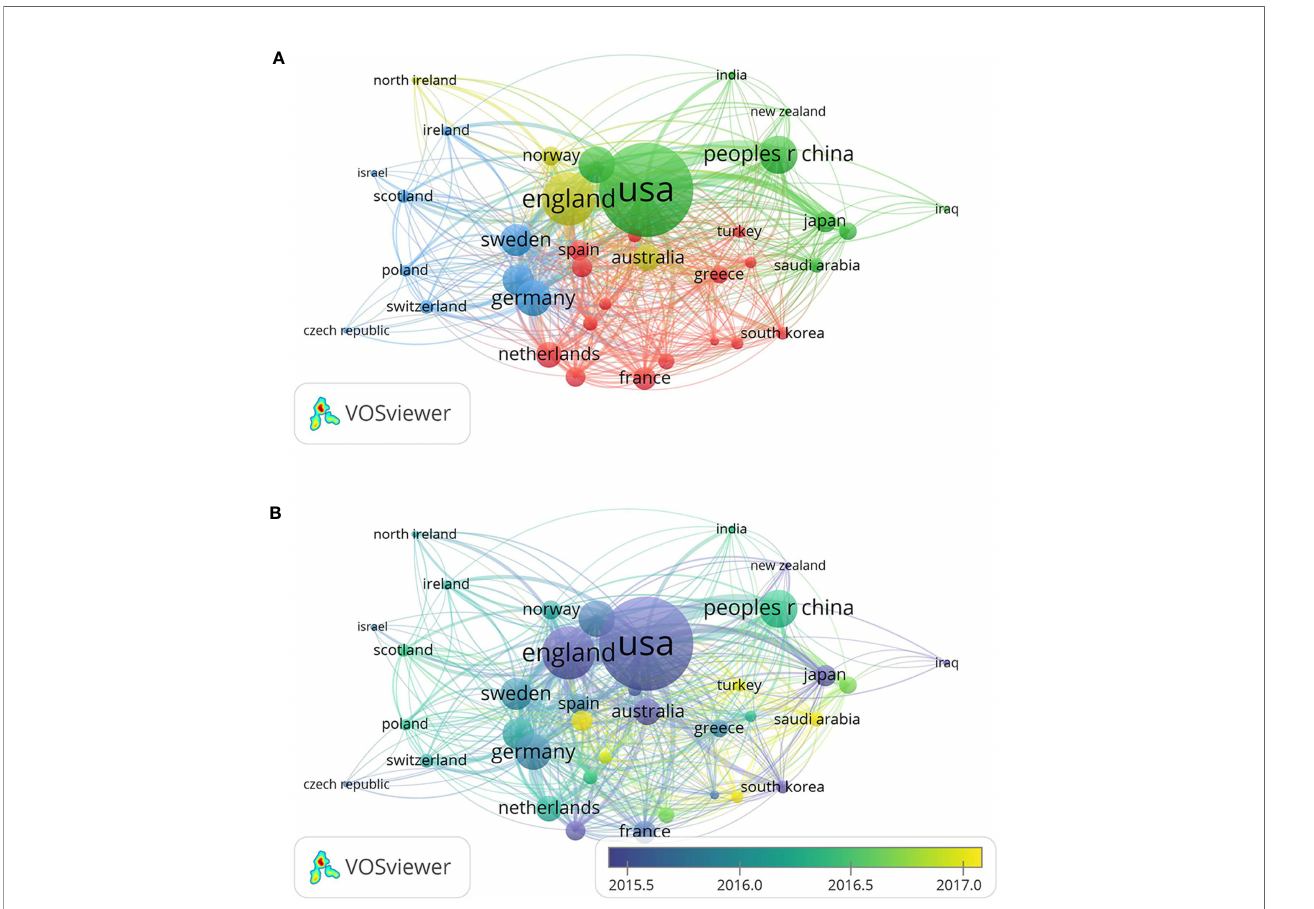
FIGURE 4 | Co-authorship analysis of countries in this fi eld. (A) Network map of co-authorship between countries with more than fi ve publications. (B) Overlay map of co-authorship between countries with more than fi ve publications. (The blue color represents the earlier years; the yellow color represents the more recent